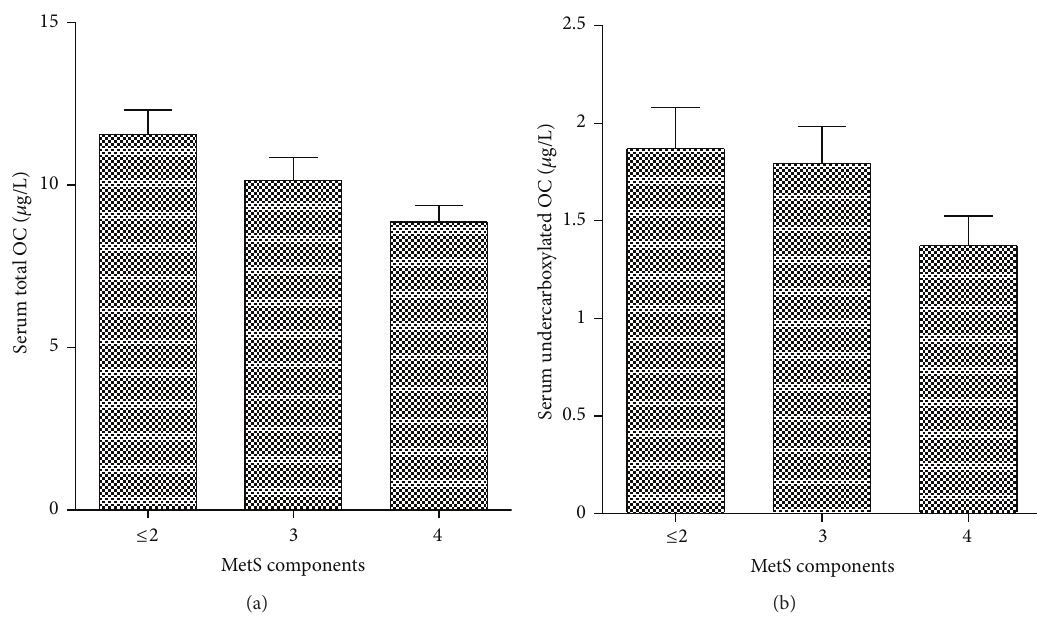
Figure 1: Serum total and undercarboxylated osteocalcin levels in relation to the number of metabolic syndrome components. Data are expressed as mean ± SEM. A significant decrease in total osteocalcin levels was observed with a higher number of metabolic syndrome components ( 𝑃 = 0.02 ). A Similar trend was observed with the undercarboxylated osteocalcin but this did not reach statistical significance ( 𝑃 = 0.11 ).